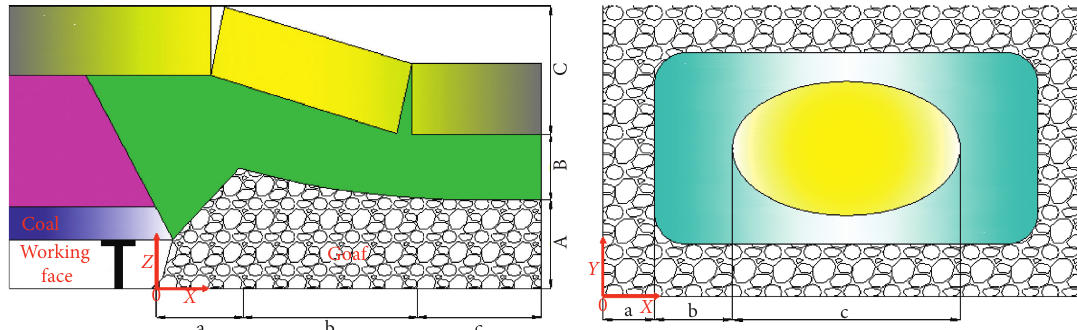
Figure 2: Diagram of three horizontal and three vertical zones in the goaf and the coordinate system of the proposed model. (A) Collapse zone. (B) Fracture zone. (C) Bending subsidence zone. (a) Natural accumulation area. (b) Load affected zone. (c) Compaction area.